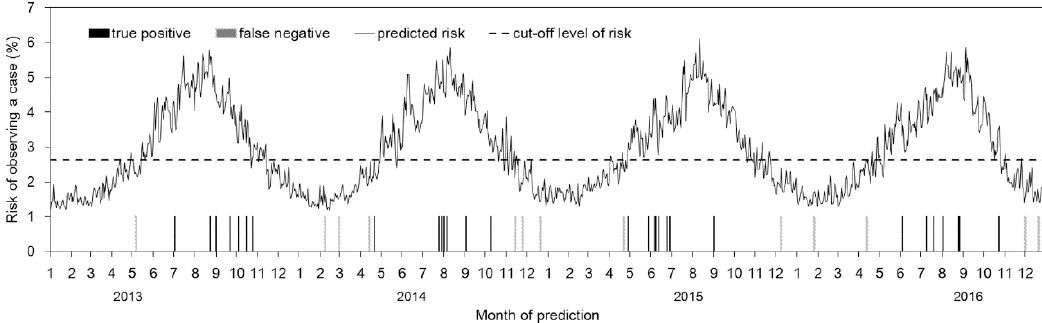
Figure 3. Penalized likelihood, Akaike Information Criterion (AIC), for three prediction models with different time lags. All three models were best fitted to the data with a time lag of six days.